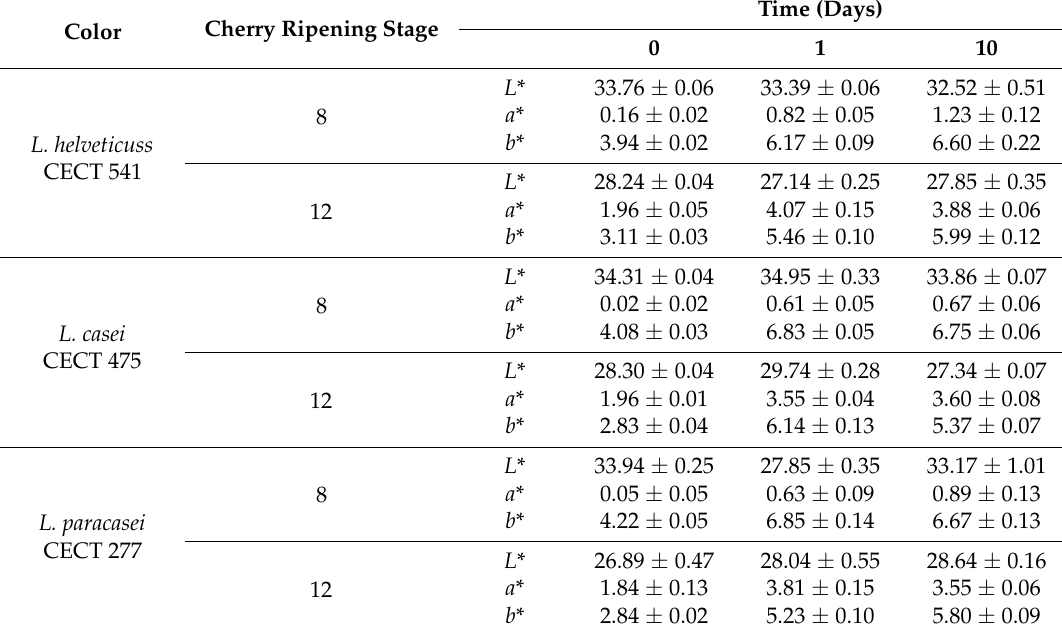
Table 1. Color parameters color (average ± standard deviation) of fermented milks with sweet cherry puree at different stages of ripening (8 and 12) before fermentation (0) and at days 1 and 10 of refrigerated storage.